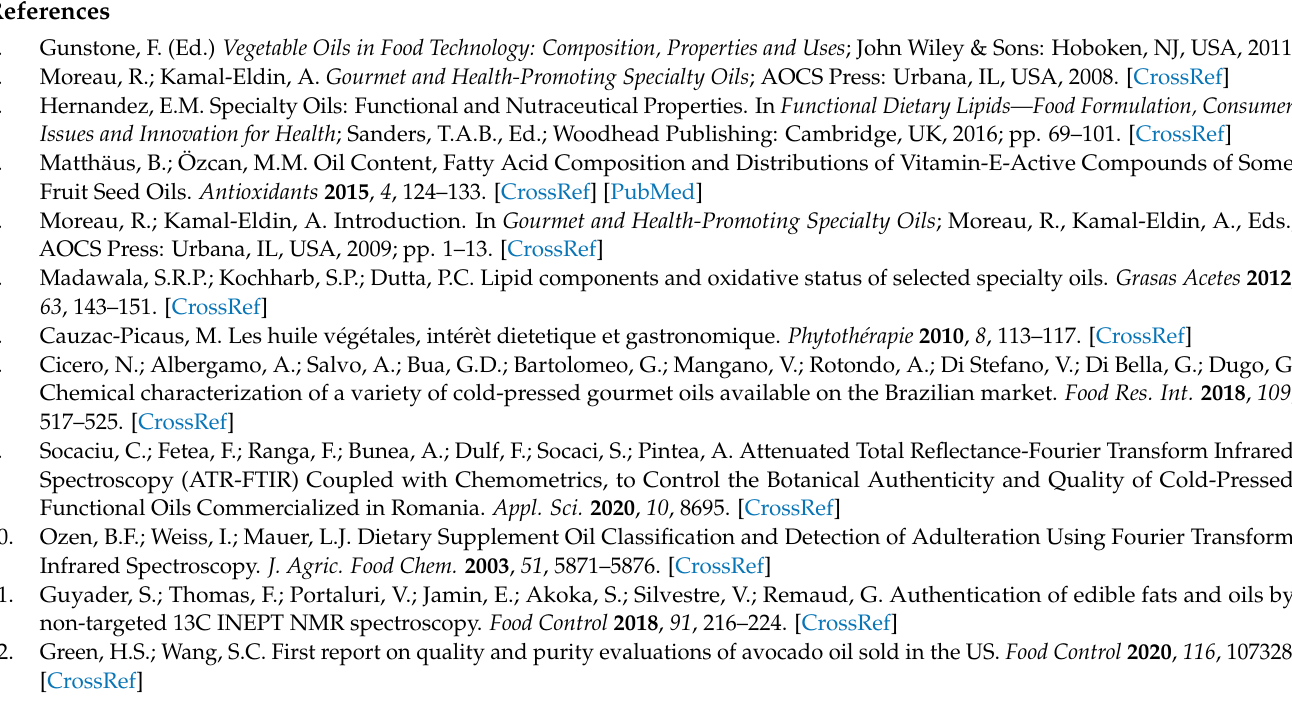
Figure S1: PCA diagnostic and plots data matrix A 204,18 . Figure S2: PCA diagnostic and plots data matrix C 140,18 . Figure S3: PCA diagnostic and plots data matrix D 70,14 . Figure S4: PCA diagnostic and plots data matrices H 37,421 and I 28,418